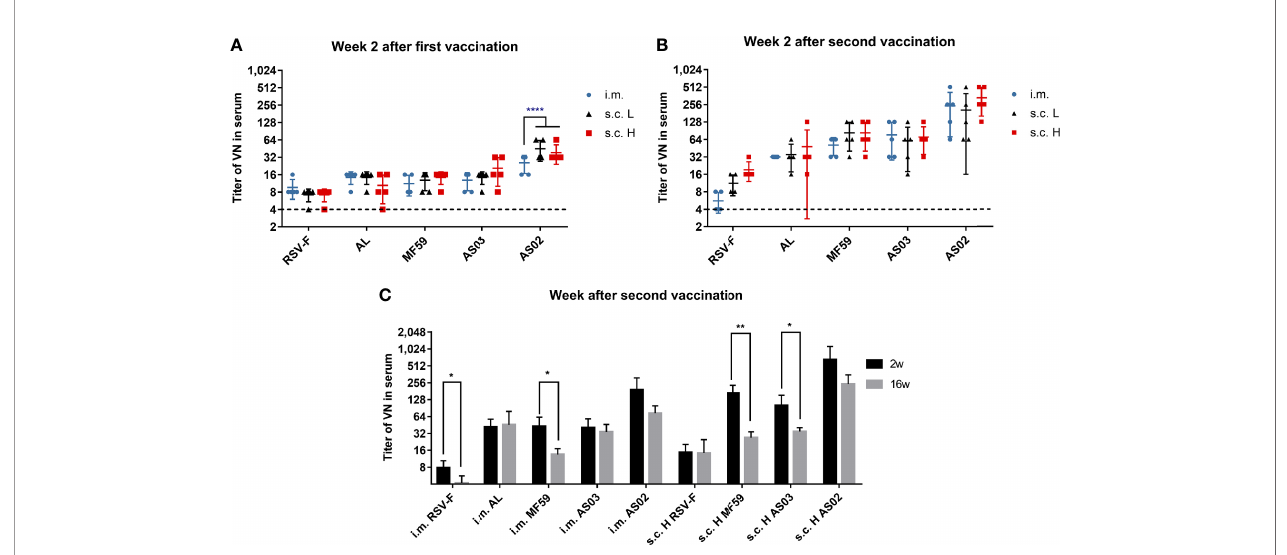
FIGURE 3 | Serum neutralizing antibody titers in immunized mice. Sera from mice vaccinated with various RSV-F vaccines with or without adjuvants via intramuscular or subcutaneous injection were tested at week 2 after priming (A) or boosting (B) . Serum neutralizing antibody levels were also examined at weeks 2 and 16 after boosting in the long-term experiment (C) . Data shown was as mean ± SD of neutralizing antibody titers calculated from fi ve mice in each group. The LOD was assigned as 4. The dashed lines represented the results of the PBS group with a value of 4. *P< 0.05, **P <0.01, ****P<0.0001 (two-way ANOVA with Tukey ’ s multiple comparisons